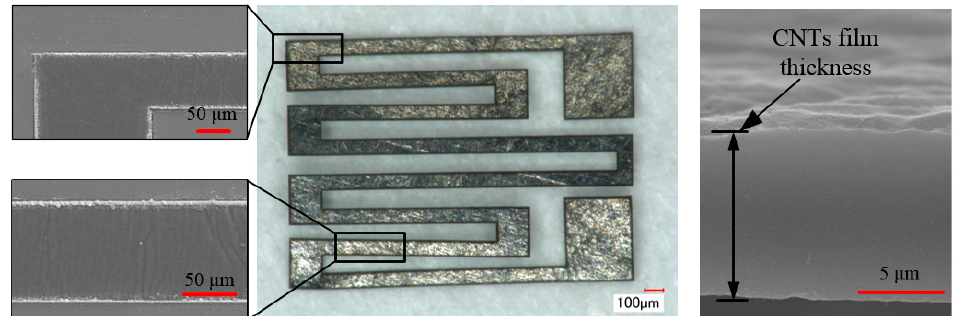
Figure 11. Femtosecond laser processing of self-supporting CNT film placed on optical microscope display platform microstructure image. (The local enlargement part is the SEM image.).